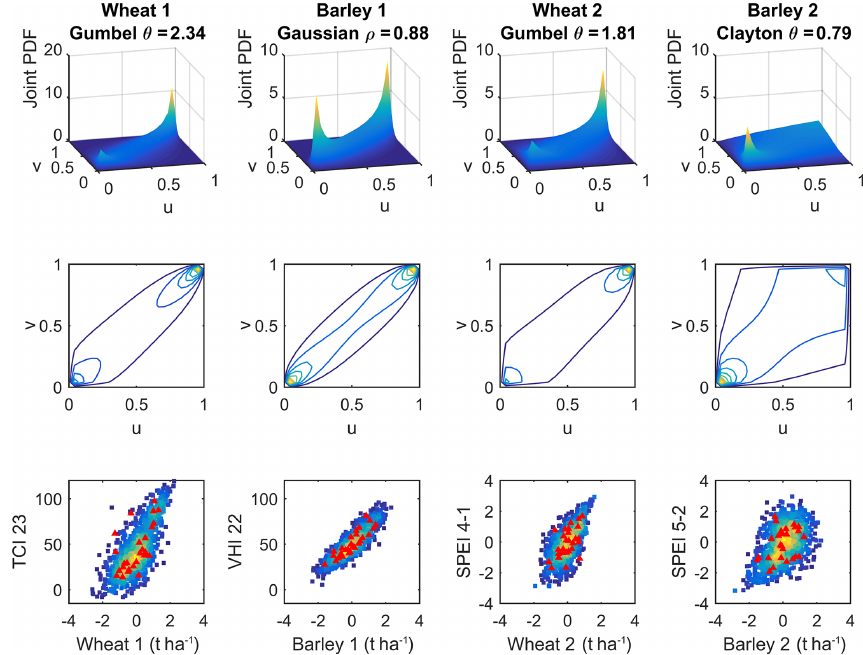
Figure 4. Selected joint probability distribution functions (PDFs) where u and v are scalar values on the interval [0, 1] (top row), contours showing the two-dimensional view of PDFs (middle row) and observed (red triangles), and copula-based simulation (density squares) scatter plots of crop yields and drought indicators (bottom